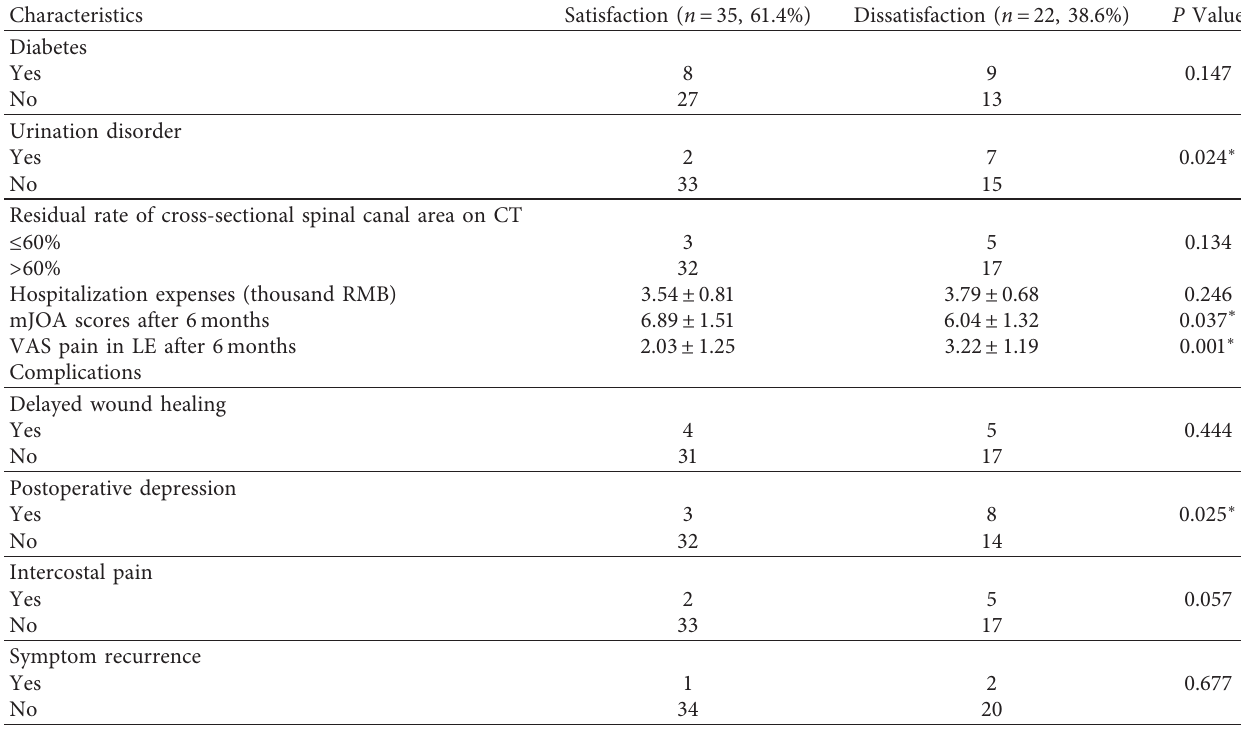
Table 5: The related risk factors of satisfied and dissatisfied patients at the 6-month follow-up.